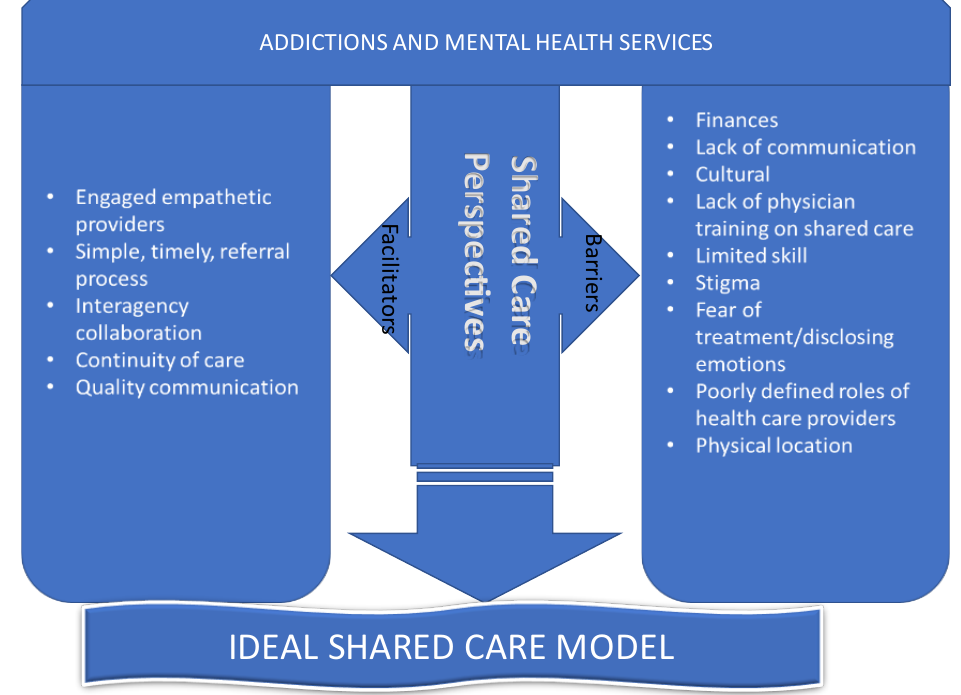
Figure 1. Conceptual framework of an ideal shared care model.